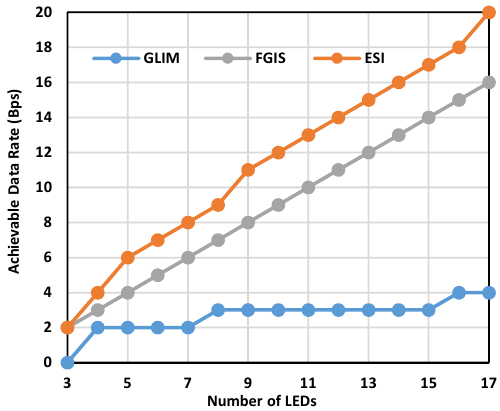
Figure 3. The proposed ESI, the GLIM [31], and the FGIS [33] achievable data rates at very high SNR